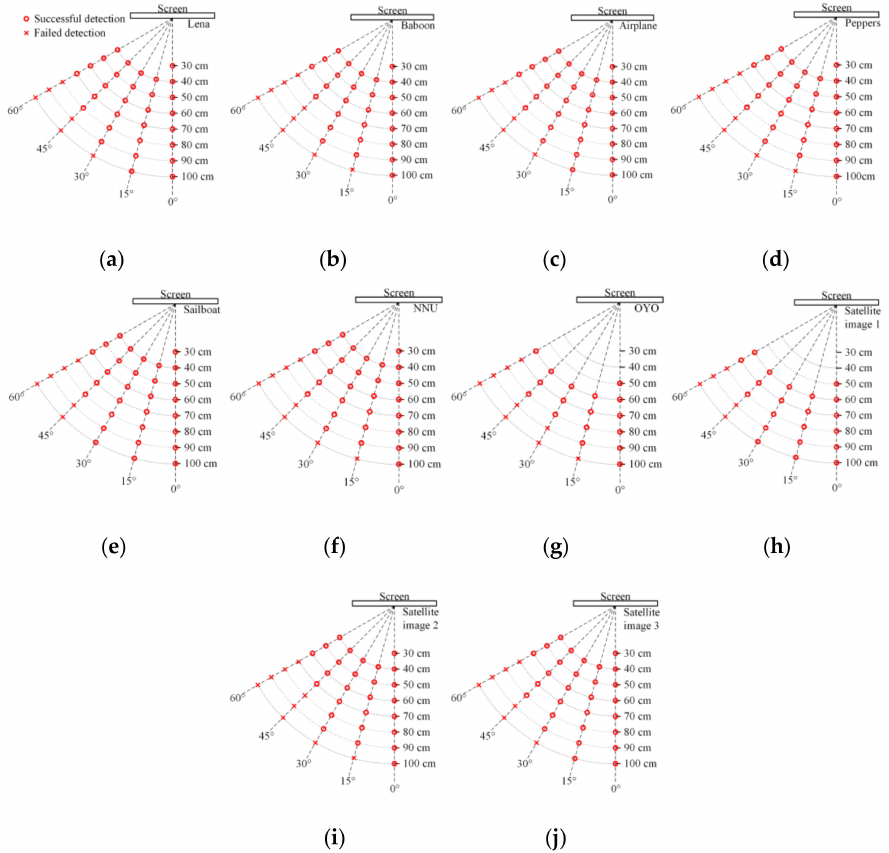
Figure 19. Watermark detection results against screen-cam attack. ( a – j ) are the detection result of Lena, Baboon, Airplane,